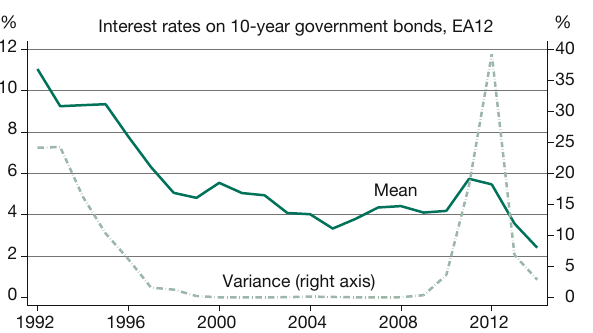
Real convergence in the euro area